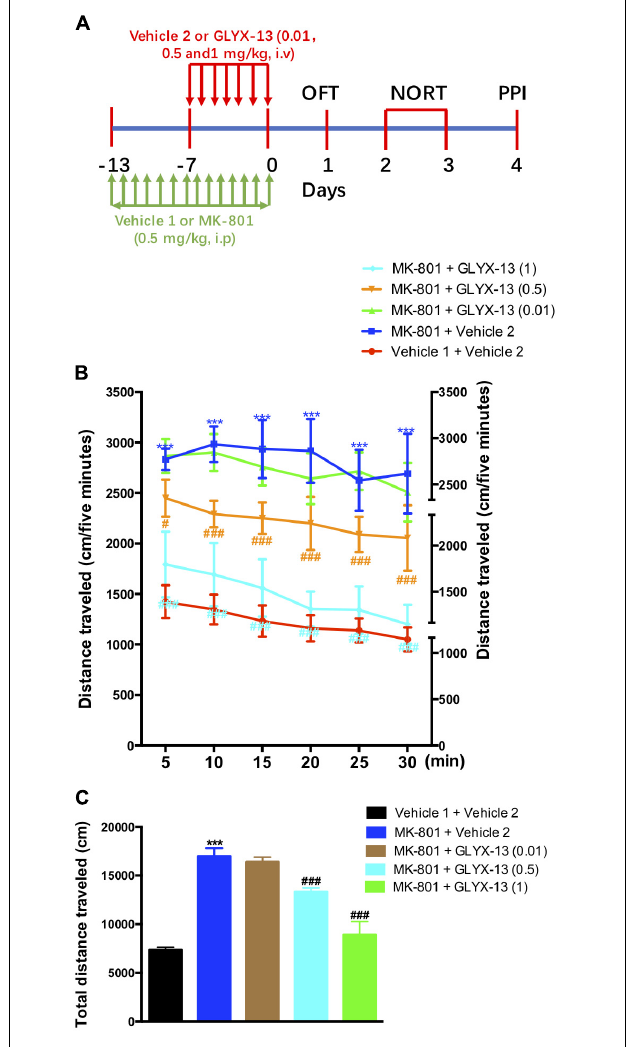
FIGURE 1 | Experimental time line and effects of GLYX-13 on MK-801-induced hyperactivity in the open-field test (OFT). (A) Mice received daily administration of vehicle 1, MK-801 (0.5 mg/kg, i.p.), for 14 days. Vehicle 2, GLYX-13 (0.01, 0.5, and 1 mg/kg, i.v.), treatment began on the 7th